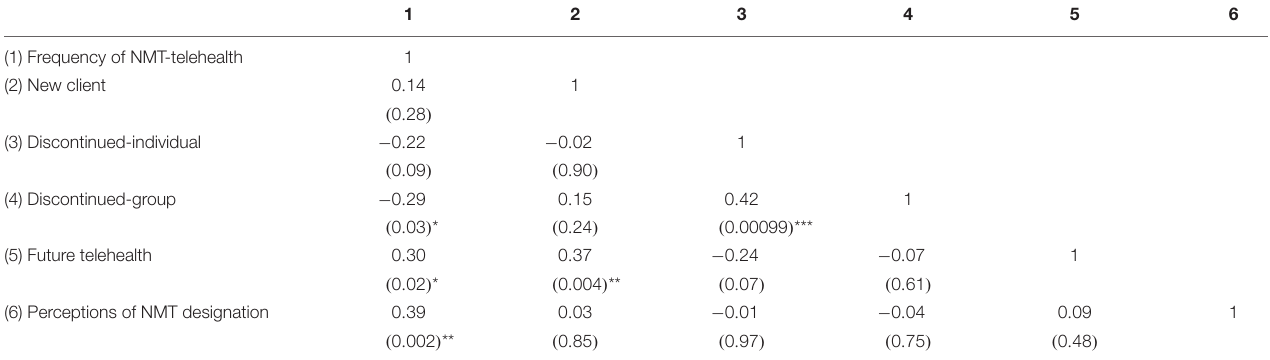
TABLE 4 | Correlations analysis table.